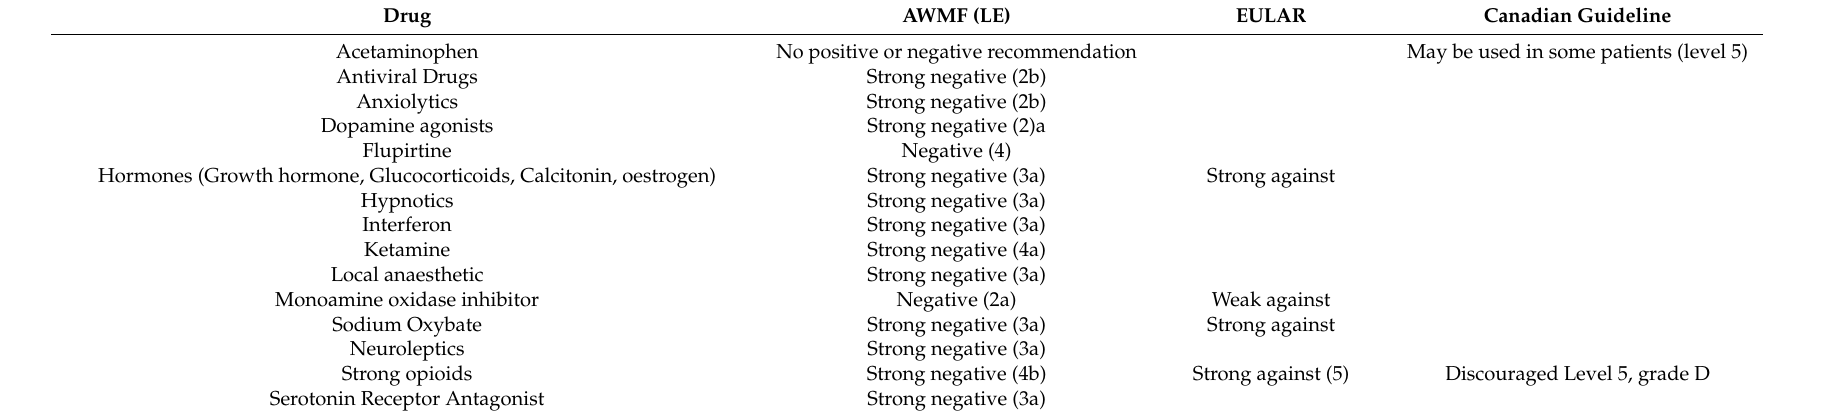
Table 2. Medications not recommended for treatment of fibromyalgia. Where no recommendation for/against is offered, a grey box is used. LE: level of